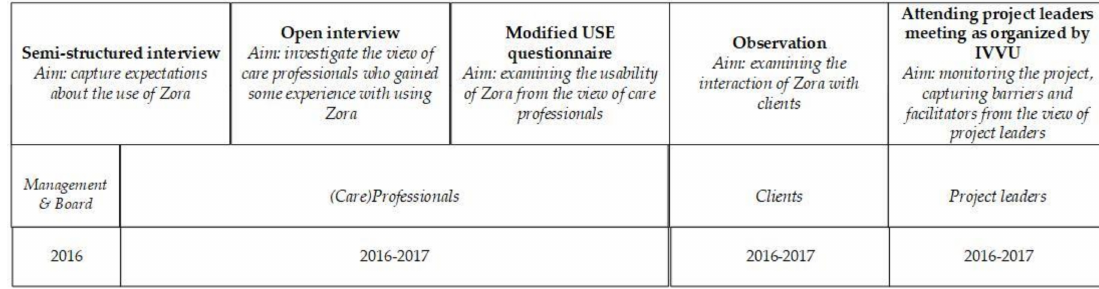
Figure 5. An overview of the methods used and the aims during the two-year